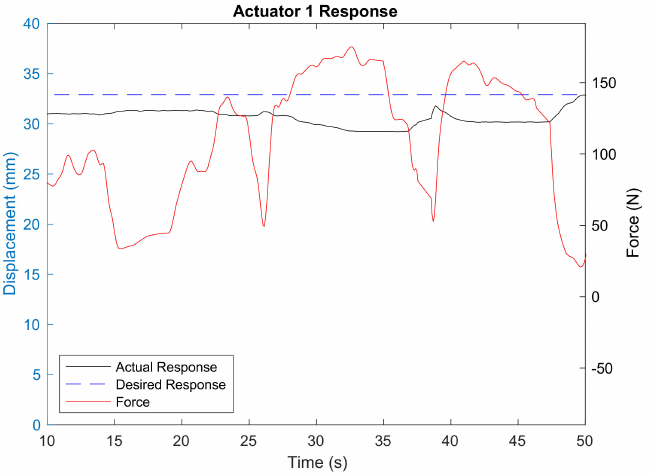
Figure 7. Actuator 1 response and force exerted by the